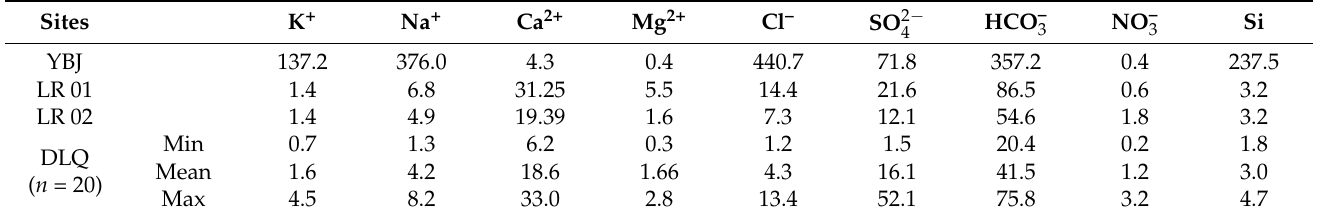
Table 2. Statistics of major ion concentrations in the DLQ, LR, and YBJ geothermal water